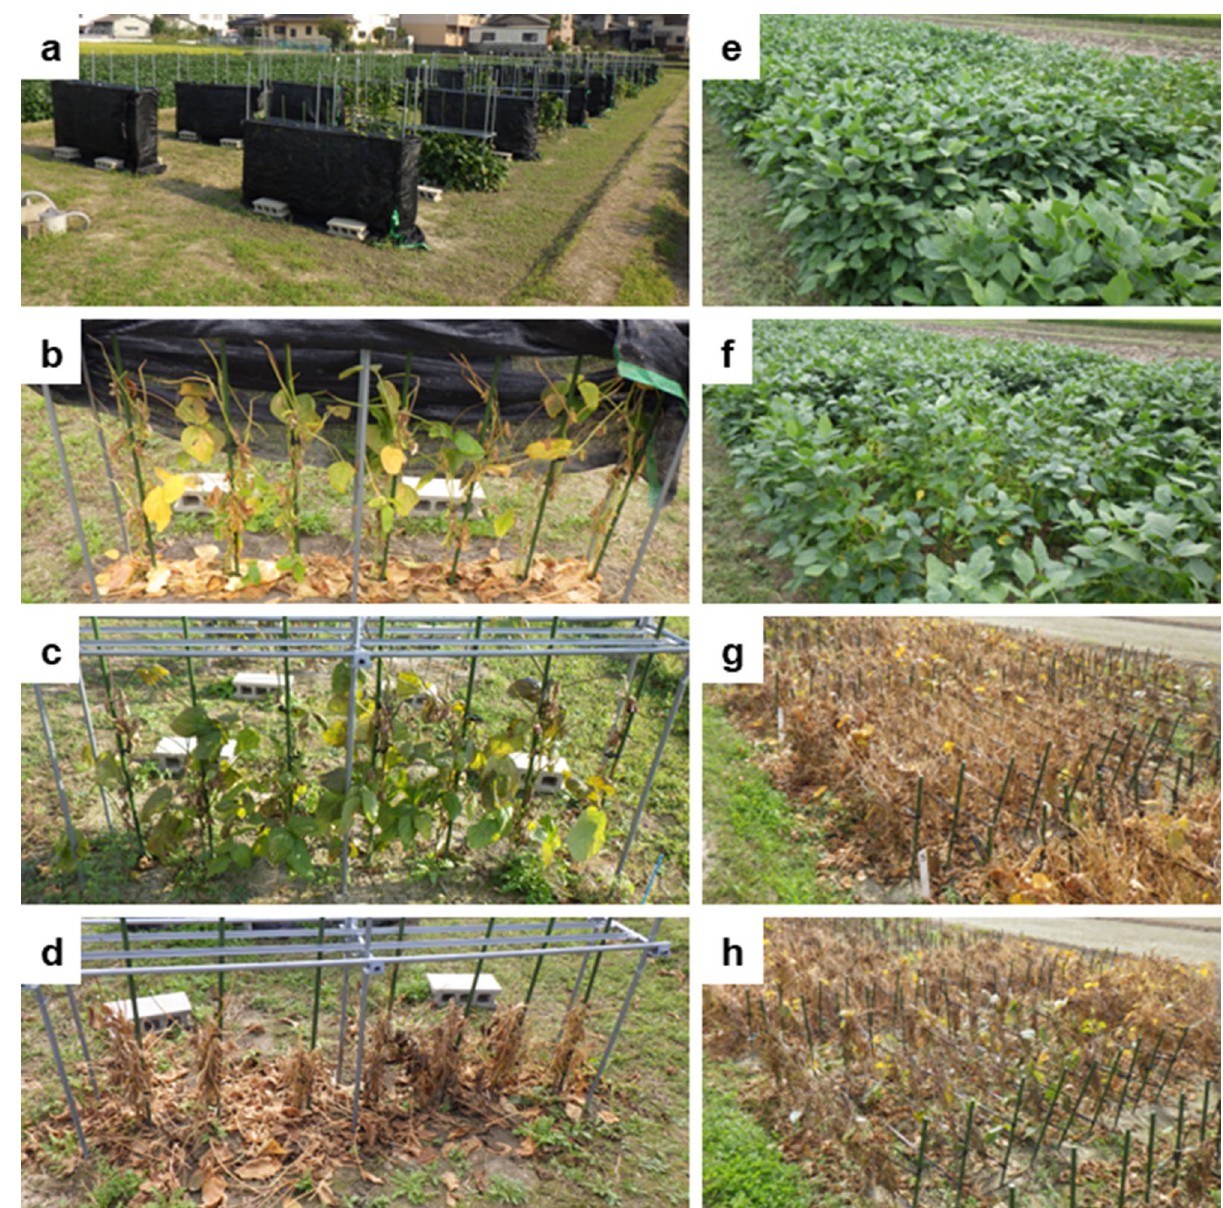
Figure 1. Photographs of the experimental plots in the soybean fields. Soybean cultivation of the shade treatments in Experiments 1 and 2 ( a – d ) and the thinning treatments in Experiment 3 ( e – h ). ( a ) Photograph on October 3, 2018. ( b , c , d ) Photographs on the days when the first plant reached the R8 growth stage. ( b ) The full shading (Control), average GSD score of 3.9 on October 26, 2018. ( c ) The shade removal from R5 to R8 (Treatment 3), average GSD score of 4.4 on October 29, 2018. ( d ) The no shade (Treatment 6), average GSD score of 2.2 on October 25, 2018. ( e , g ) The dense treatment plot. ( f , h ) The thinning treatment plot. ( e , f ) R5 growth stage on September 6, 2018. ( g , h ) R8 growth stage on November 1, 2018. Photographs were taken by R.